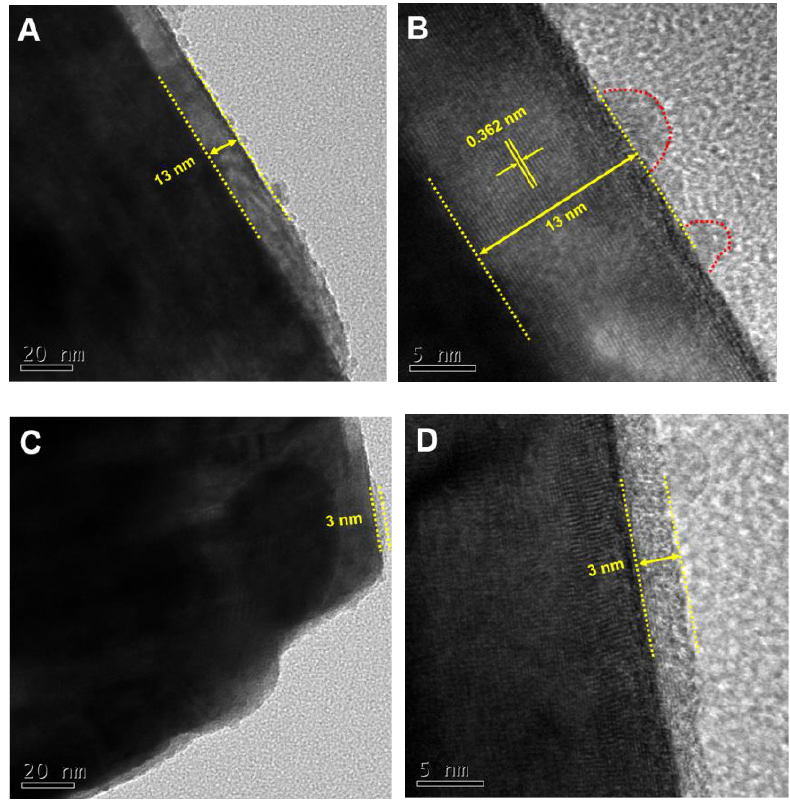
Figure 6. TEM and HR-TEM of WO 3 /TiO 2 /CC ( A , B ) and R-WO 3 /R-TiO 2 /CC ( C , D